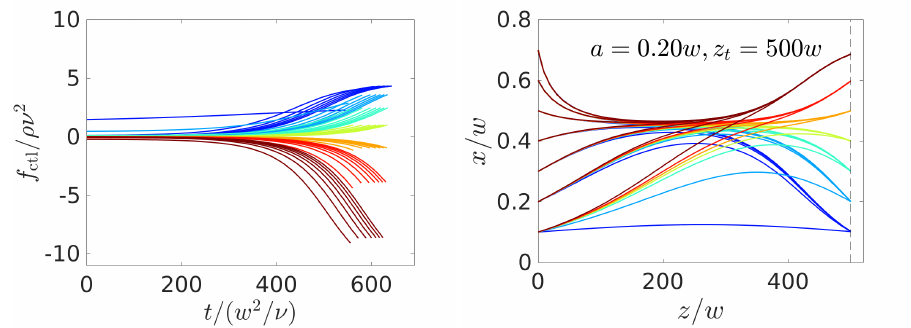
Figure 5. Optimal control-force protocols ( left ) and particle trajectories in the x - z plane ( right ) found for steering colloids with radius a = 0.2 w from a set of initial positions to a set of targets, which both assume the same values 0.1,0.2,0.3,0.4,0.5,0.6,0.7 . The same color refers to trajectories ending at the { } same target position x t . The vertical dashed line indicates z t .